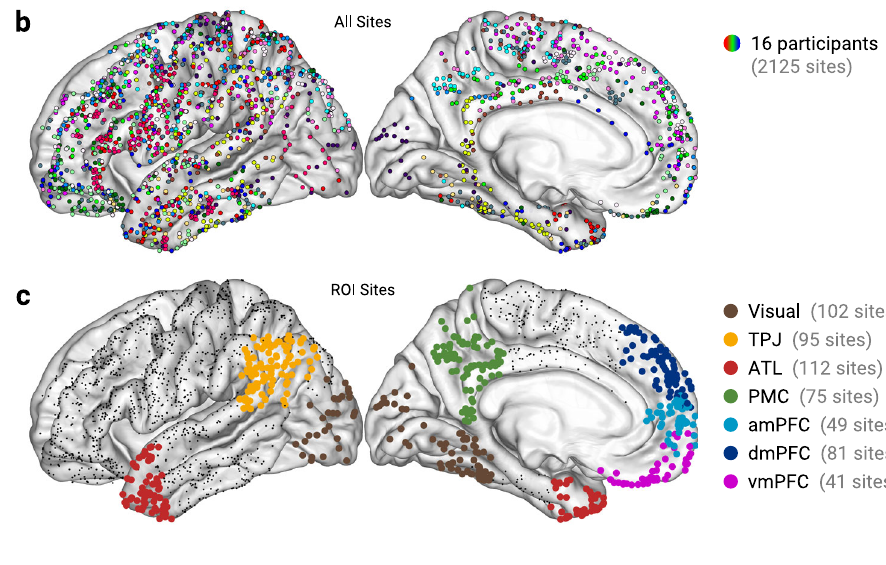
Intermediate mentalizing-speci fi city was found in TPJ (38%), ATL (32%), and PMC (58%). Very high mentalizing-speci fi city was found in amPFC (87%), dmPFC (94%), and vmPFC (100%). Taken together, these results show a gradient of mentalizing- speci fi city from visual cortex to mPFC.